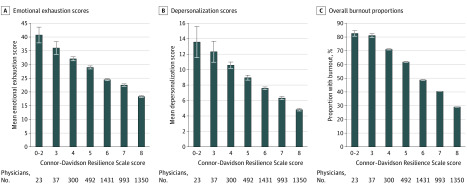
Emotional Exhaustion Scores, Depersonalization Scores, and Overall Burnout Proportions Across Levels of Resilience Among US PhysiciansError bars indicate standard error of the mean.